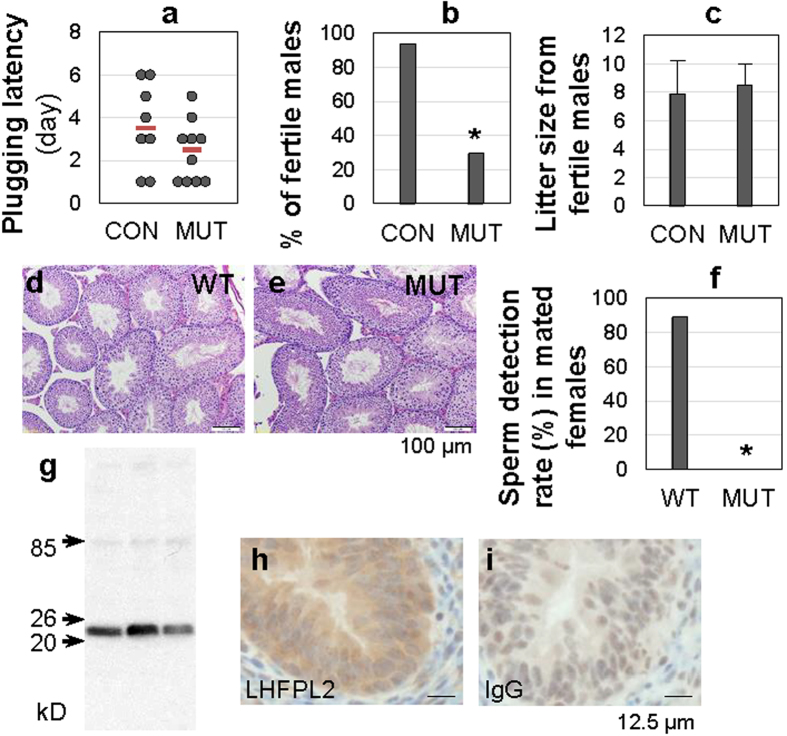
Male fertility test and localization of LHFPL2 in vas deferens.(a) Plugging latency of control (CON, including WT & HET) and MUT males to indicate mating activity. Each dot, the period between cohabitation and the detection of the first plug in the mated female; red line, median. (b) Percentage of fertile CON and MUT males. N = 15–17. (c) Litter size from fertile WT and MUT males. Error bar, standard deviation; N = 10–16. (d,e) Histology of 6 months old WT (d) and MUT (e) testes. Scale bar, 100 μm. (f) Sperm detection rate in reproductive tract of control females (N = 9–17) mated with WT (N = 4) or infertile MUT (N = 6) males. *P < 0.05. (g) Western blot in three uterine samples to verify a rabbit polyclonal anti-mouse LHFPL2 antibody. The main band detected was between 20 kD and 26 kD (predicated to be ~23.9 kD). (h) Immunohistochemistry detection of LHFPL2 in epithelium of PND7 vas deferens. (i) Immunohistochemistry in PND7 vas deferens using rabbit IgG as a negative control. Scale bar (h,i), 12.5 μm.